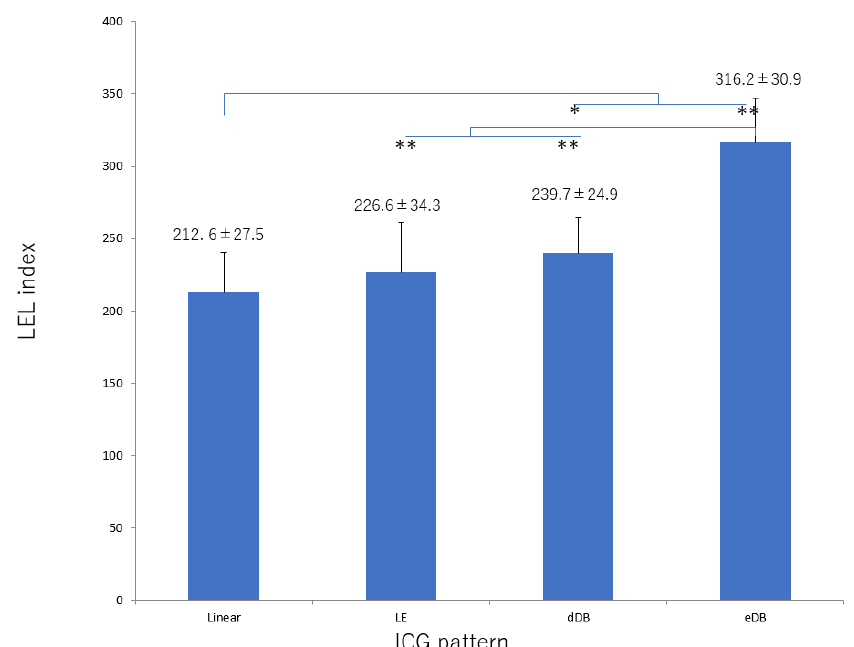
Figure 1. LEL index score according to type of lymphography pattern in the group ≥65 years of age. There was significant deterioration in this score with progression from the linear, LE, dDB through to the eDB pattern. dDB, distal dermal backflow; eDB, extended dermal backflow; LE, low enhancement; LEL, lower extremity lymphedema. * p < 0.05, ** p < 0.01 (Tukey–Kramer test).